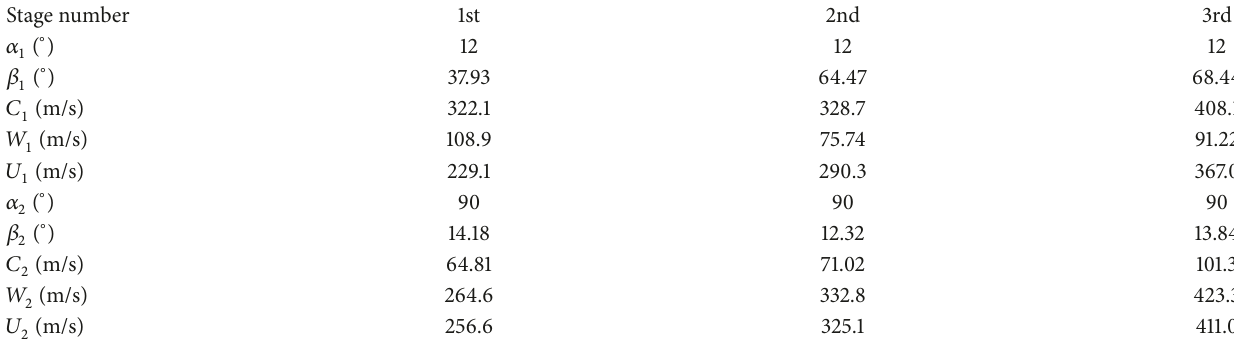
Table 5: The speed triangle data of the centrifugal turbine.